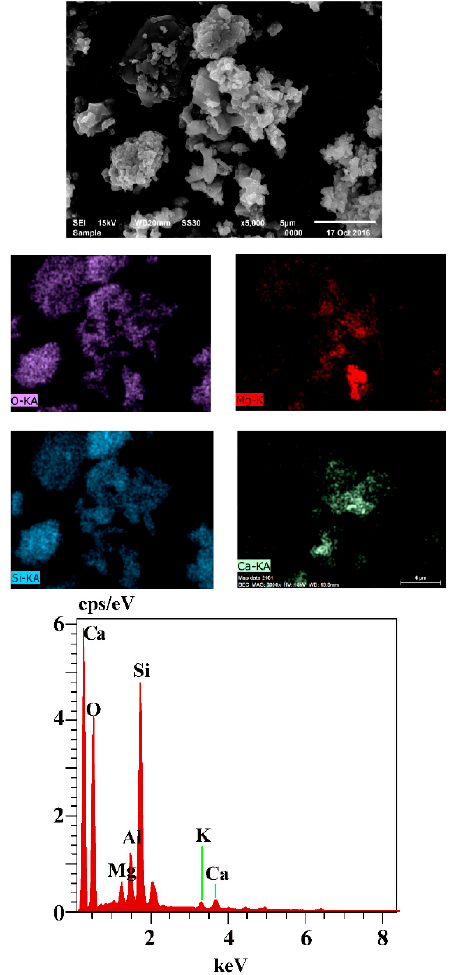
Figure 7. SEM image and corresponding EDS analysis of the sample roasted with 3 wt % MgO at 900 °C for 1 h.